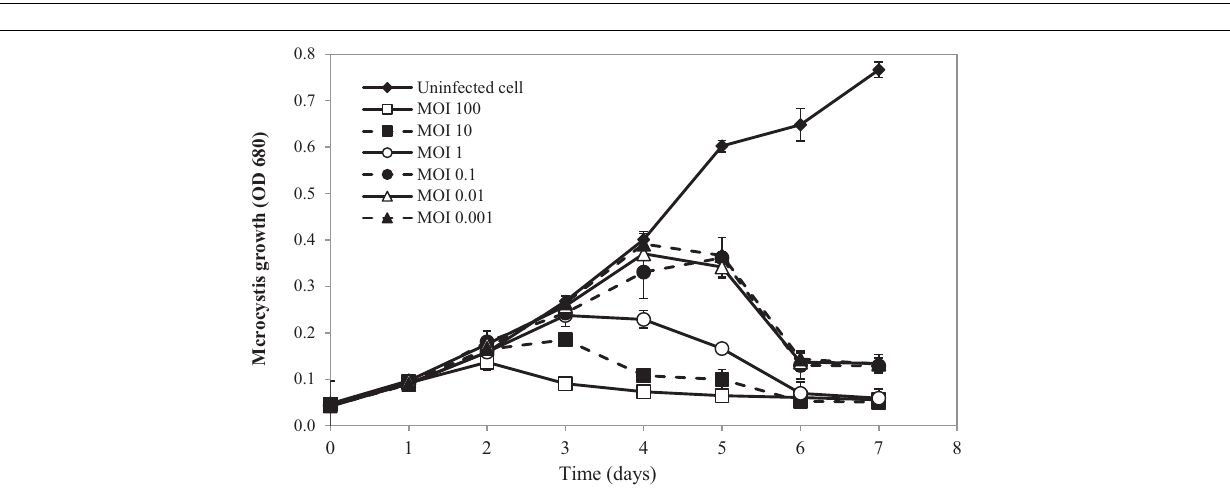
FIGURE 3 | One-step growth curve of cyanophage PhiMa05. Data are the mean of triplicate independent experiments with standard deviation.